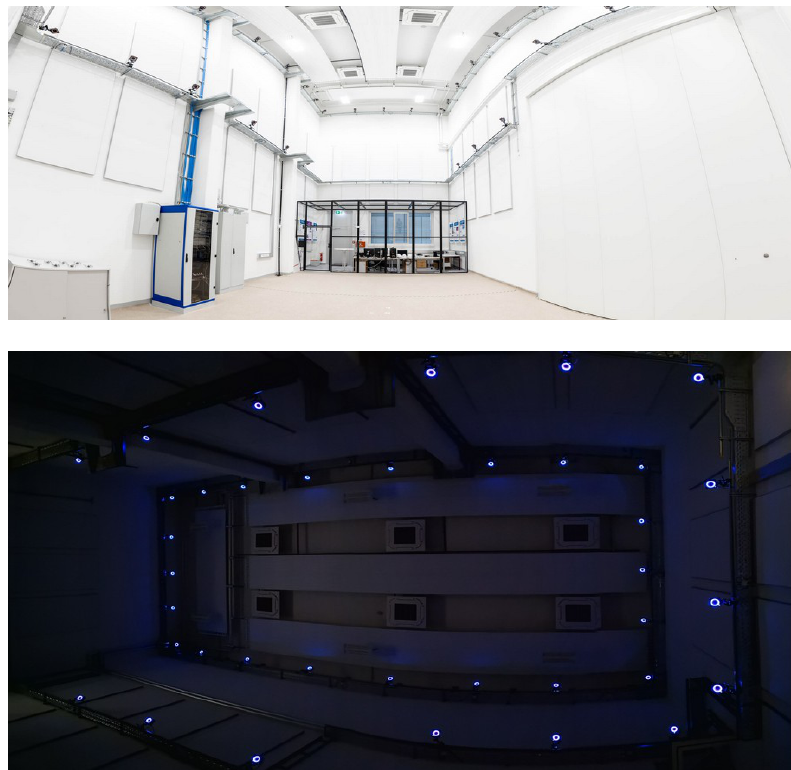
Figure 3. Pictures of our drone hall with the motion capture system used for our pipeline. With a set of 37 cameras we are able to track the hall’s complete volume. The second image is taken upward to capture as many cameras as possible and to showcase the available tracking volume. ( Top ) picture reprinted with permission from Daniel Waschnig. Copyright 2019 Daniel Waschnig. ( Bottom ) picture reprinted with permission from Fred Arneitz. Copyright 2019 Fred